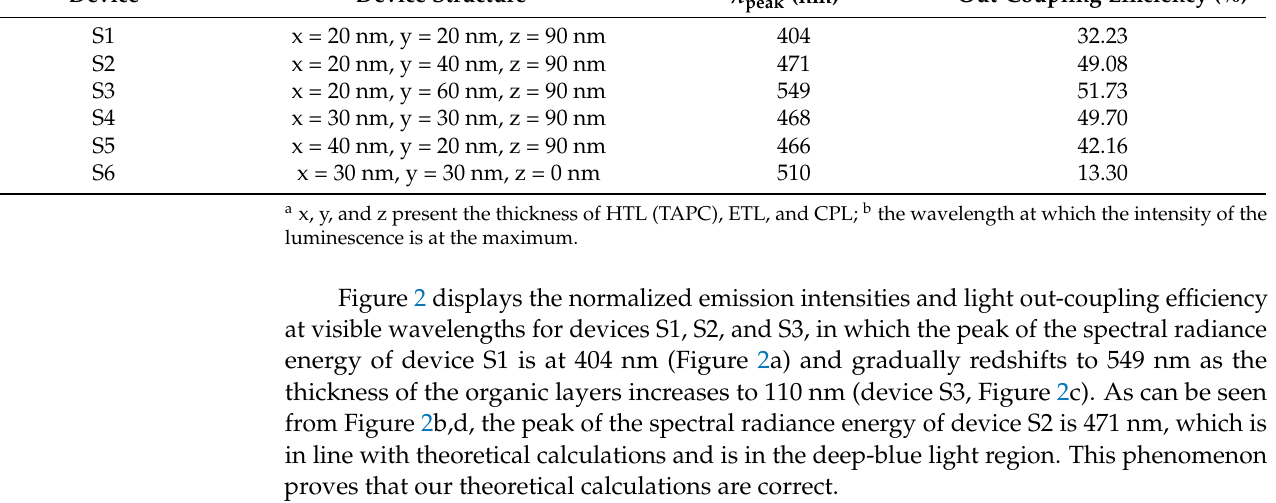
Table 1. FDTD simulation results of TOLEDs.